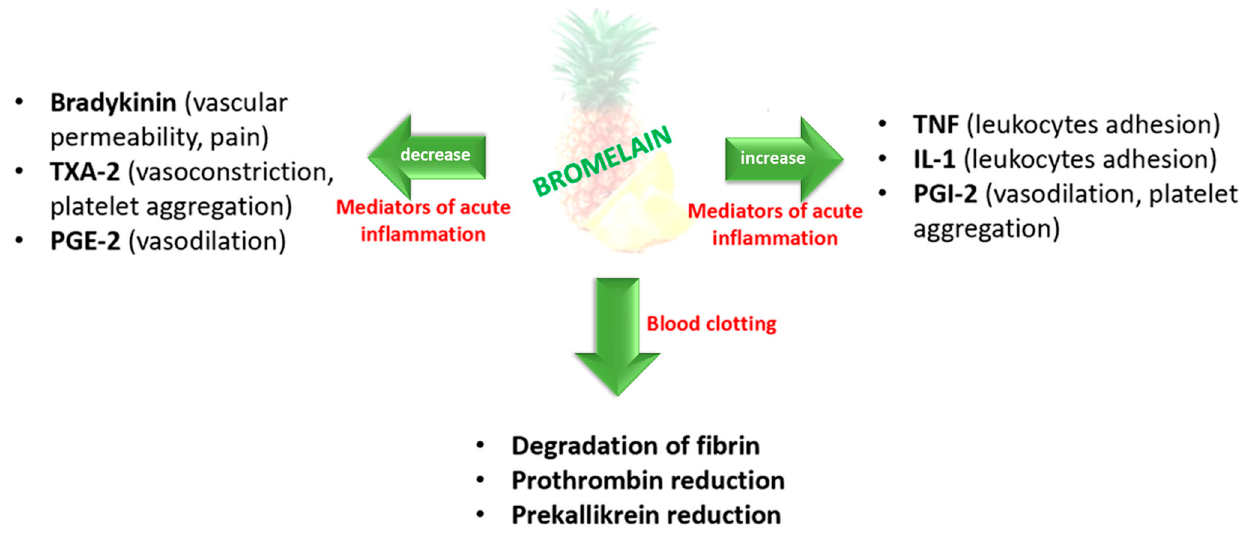
Figure 4. Anti-inflammatory and anticoagulant mechanisms of action of bromelain (Adapted with permission from [65], MDPI, Basel, Switzerland, 2021).